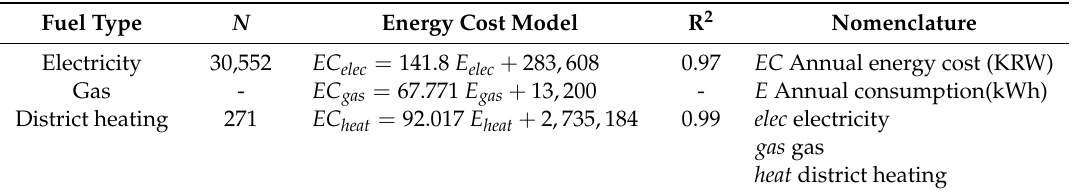
Table 6. The summary of energy cost estimation model by fuel type.